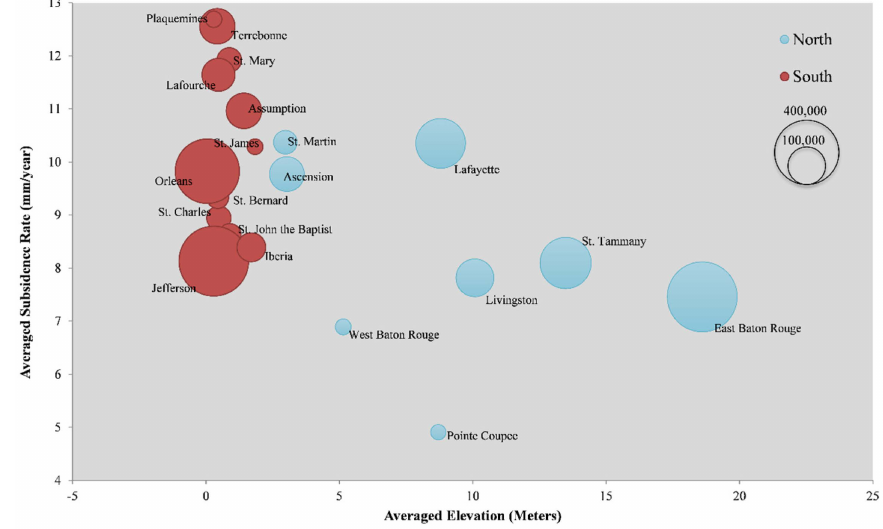
Figure 5. Parish-level average elevation, subsidence rates and population in the LMRB in 2012 (Washington, West Feliciana, East Feliciana and St. Helena parishes are not included).